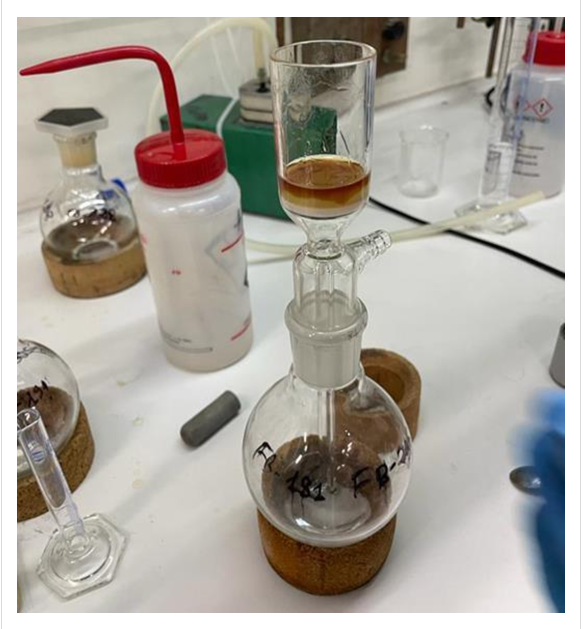
Figure 2: The purification process of a brownish isocyanide on a short silica